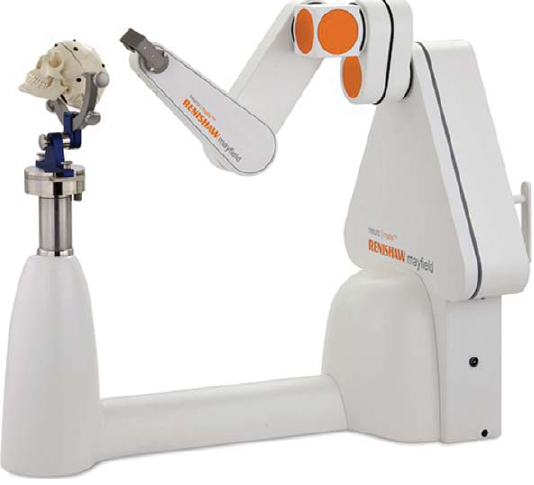
Fig. 1. Neuromate ® (courtesy of Renishaw Mayfield,